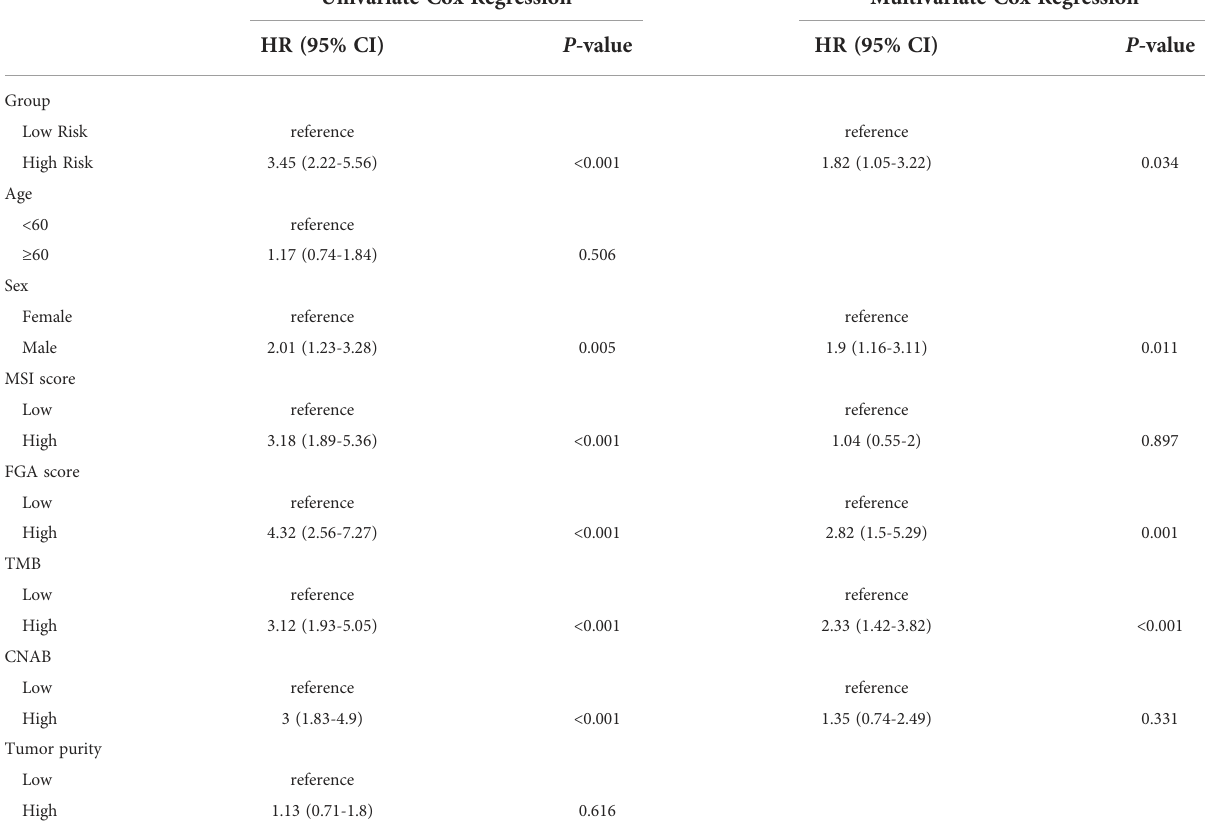
TABLE 2 Survival analysis between different